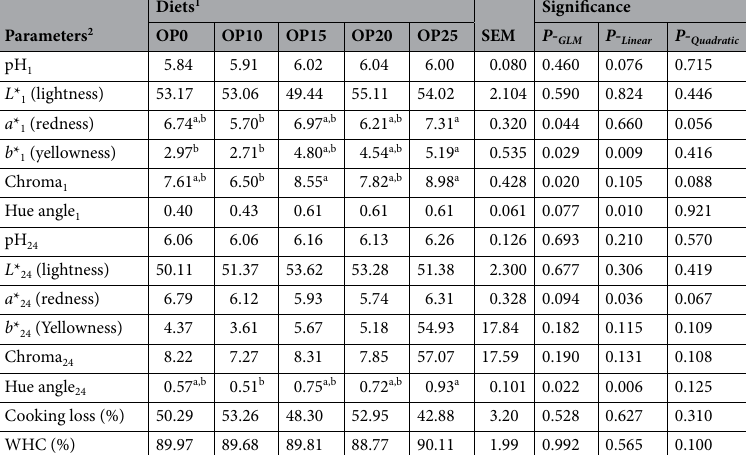
Table 6. Effects of incremental levels of dietary olive pomace on meat quality parameters in Jumbo quail. a,b In a row, means with common superscripts do not differ ( p < 0.05). 1 Diets: OP0 a standard grower diet without olive pomace, OP10 a standard grower diet with 100 g/kg olive pomace, OP15 a standard grower diet with 150 g/kg olive pomace, OP20 a standard grower diet with 200 g/kg olive pomace, OP25 a standard grower diet with 250 g/kg olive pomace. 2 Parameters: pH 1 pH 1-h post-mortem, pH 24 pH 24-h post-mortem, WHC water holding